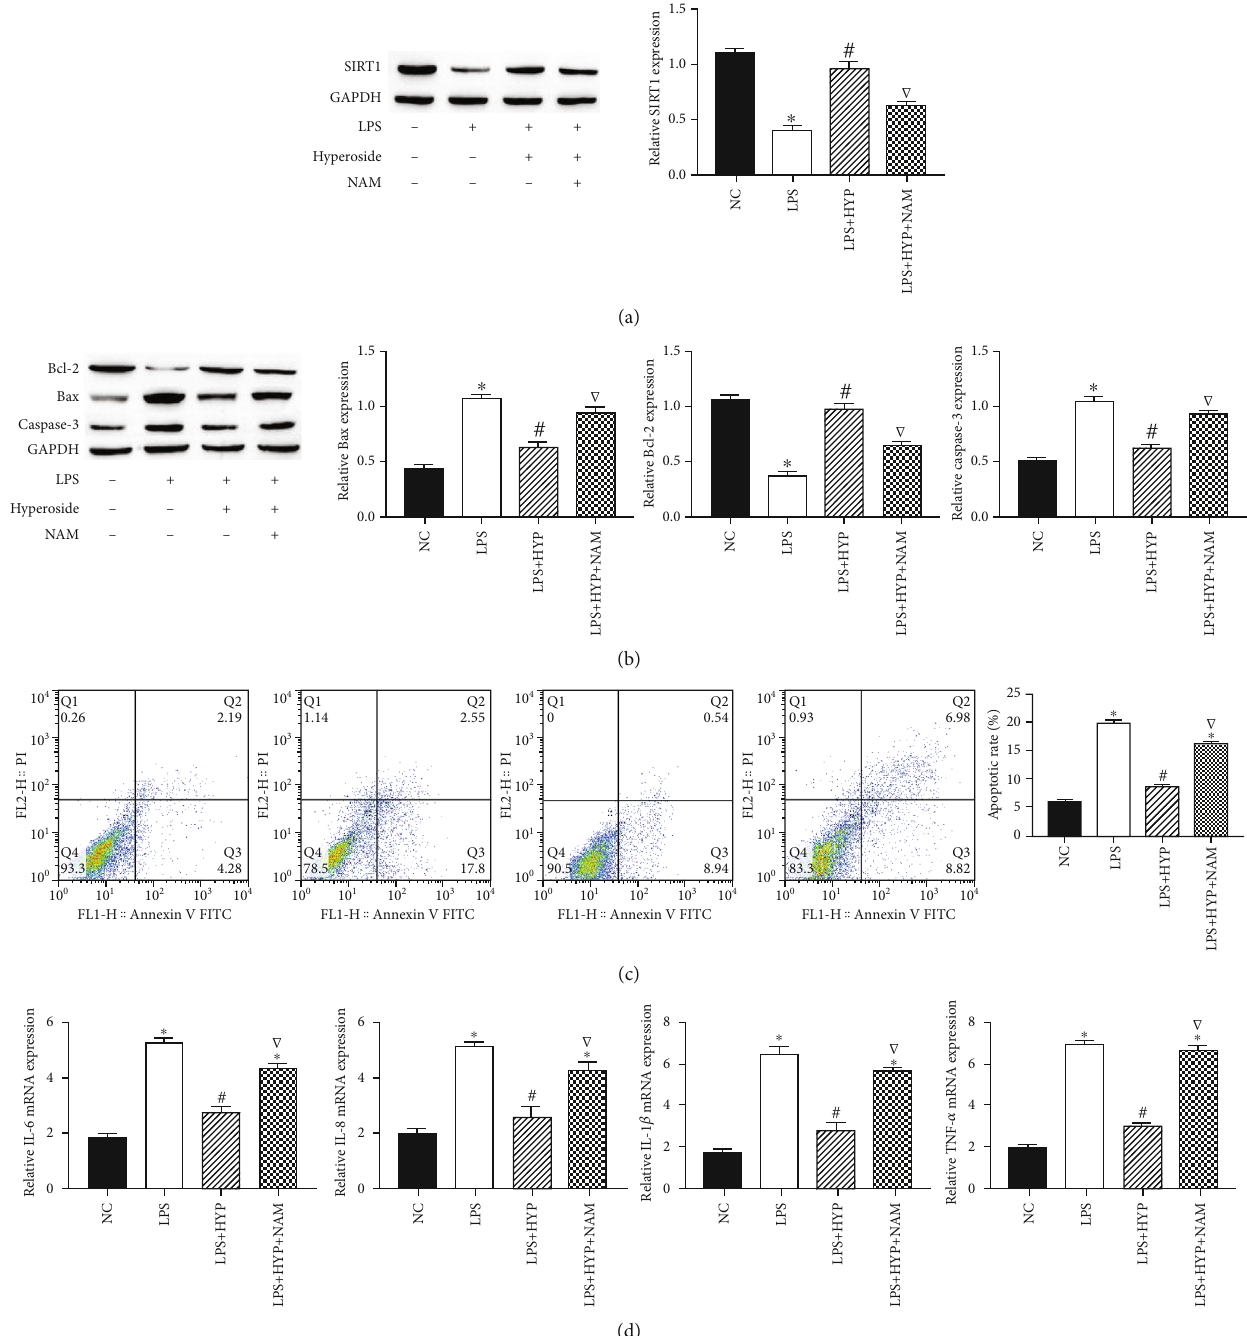
Figure 3: Hyperoside inhibits LPS-induced HT22 cell apoptosis and in fl ammation through SIRT1. The expression of SIRT cells was measured by western blotting (a). The expression of Bcl-2, Bax, and caspase-3 in HT22 cells was measured by western blotting (b). The HT22 cell apoptosis rate was measured by fl ow cytometry assay (c). The level of IL-1 β , IL-6, IL-8, and TNF- α mRNA in HT22 cells was measured by qRT-PCR (d). ∗ was considered signi fi cant compared to control ( ∗ P < 0 : 05 ); # was considered signi fi cant compared to LPS ( # P < 0 : 05 ); ▽ was considered signi fi cant compared to LPS+HYP ( ▽ P < 0 : 05